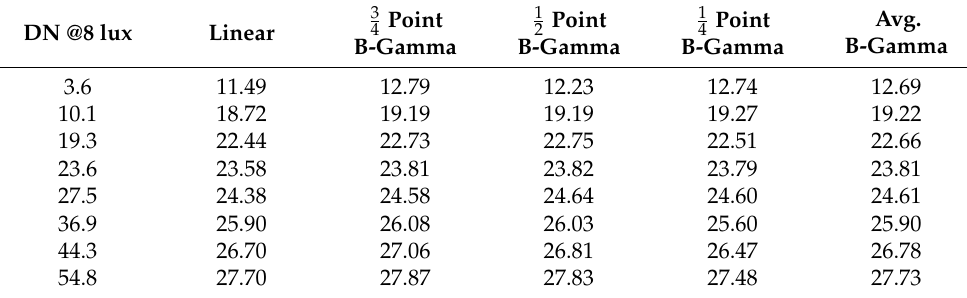
Table 1. Measured SNR [dB] with different modes @ 8